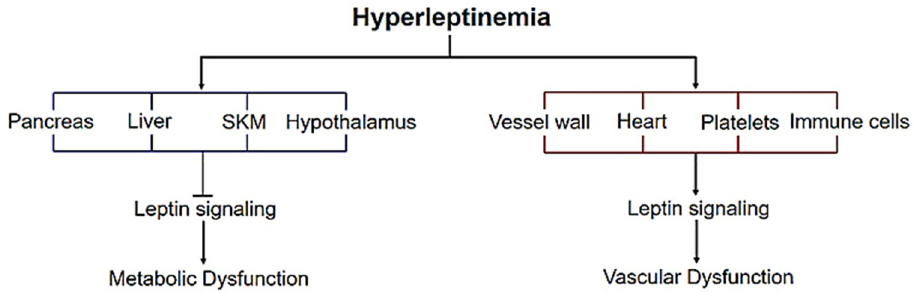
Figure 1. Metabolic vs. vascular dysfunction in response to hyperleptinemia. Elevated leptin levels, representative of obesity and diabetes, inhibit leptin signaling in the pancreas, liver, skeletal muscle (SKM) and hypothalamus, triggering metabolic dysfunction. On the other hand, activation of leptin receptor signaling pathways in the vessel wall, heart, blood platelets and immune cells mediate leptin-induced vascular dysfunction.